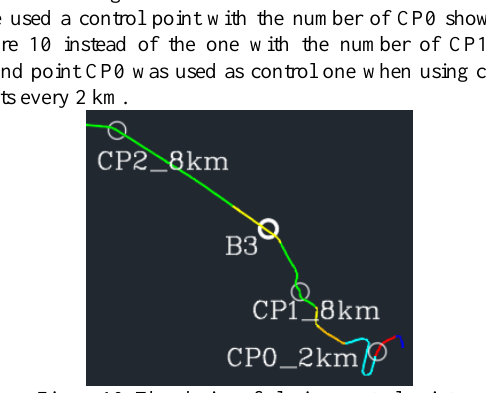
Figure 10. The choice of placing control points No further increase in distance between control points is required because of limited distance between reference